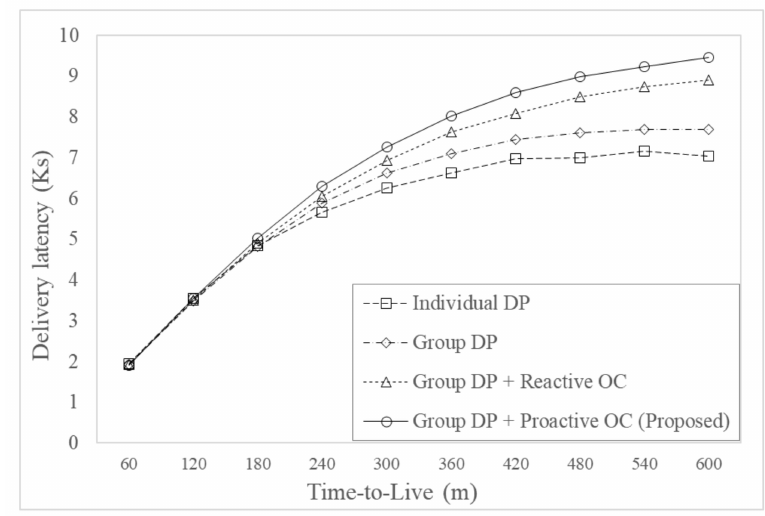
Figure 13. Delivery latency for varying